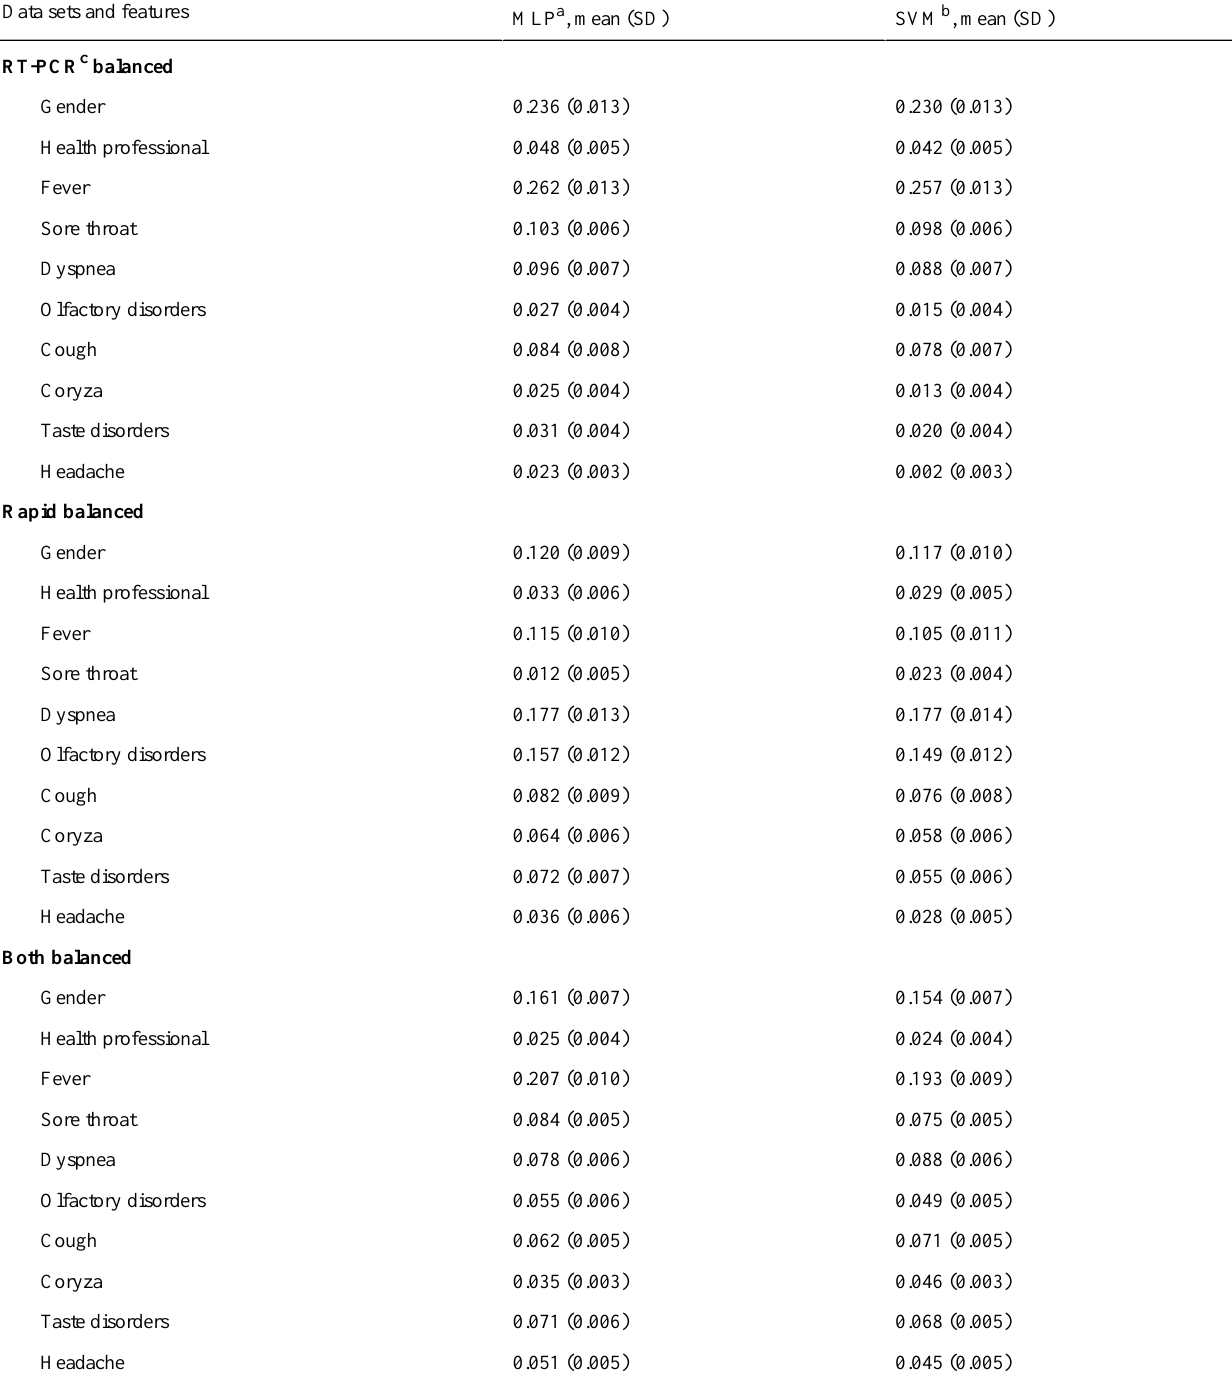
Table 4. The average importance and SD for each feature for the MLP and SVM models and the balanced data